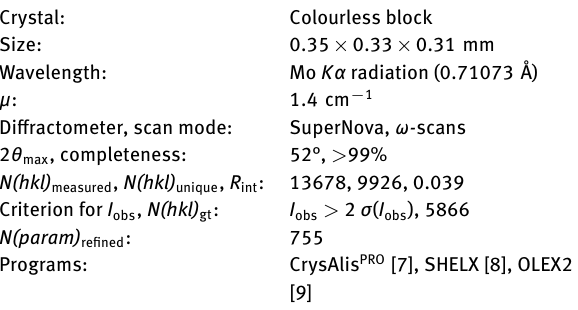
Table 1: Data collection and